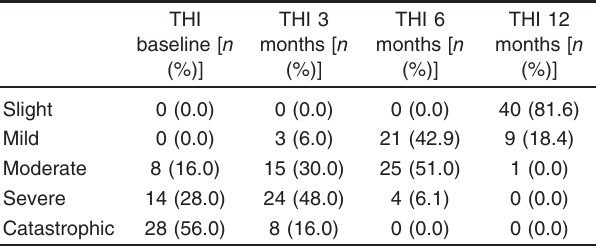
Table 6 Progress of Tinnitus Handicap Inventory grading over 12